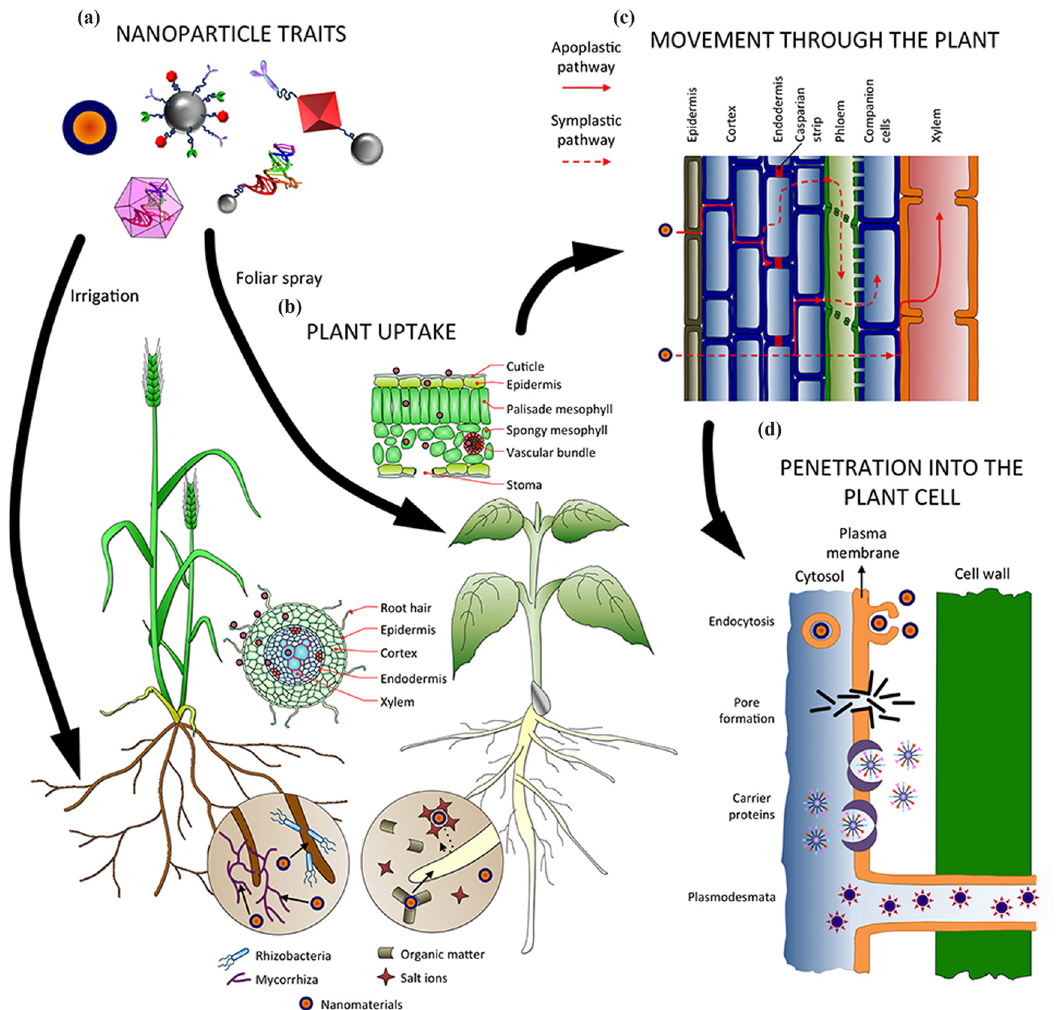
Figure 3: E ff ect of di ff erent factors on absorption, uptake, transport and penetration of nanoparticles in plants. ( a ) Nanoparticle traits a ff ect how they are uptaken and translocated in the plant, as well as the application method. ( b ) In the soil, nanoparticles can interact with microorganisms and compounds, which might facilitate or hamper their absorption. Several tissues ( epidermis, endodermis … ) and barriers ( Casparian strip, cuticle … ) must be crossed before reaching the vascular tissues, depending on the entry point ( roots or leaves ) . ( c ) Nanomaterials can follow the apoplastic and/or the symplastic pathways for moving up and down the plant, and radial movement for changing from one pathway to the other. ( d ) Several mechanisms have been proposed for the internalization of nanoparticles inside the cells, such as endocytosis, pore formation, mediated by carrier proteins, and through plasmodesmata. Reproduced from Pérez - de - Luque [ 126 ] under the Creative Commons Attribution 4 International